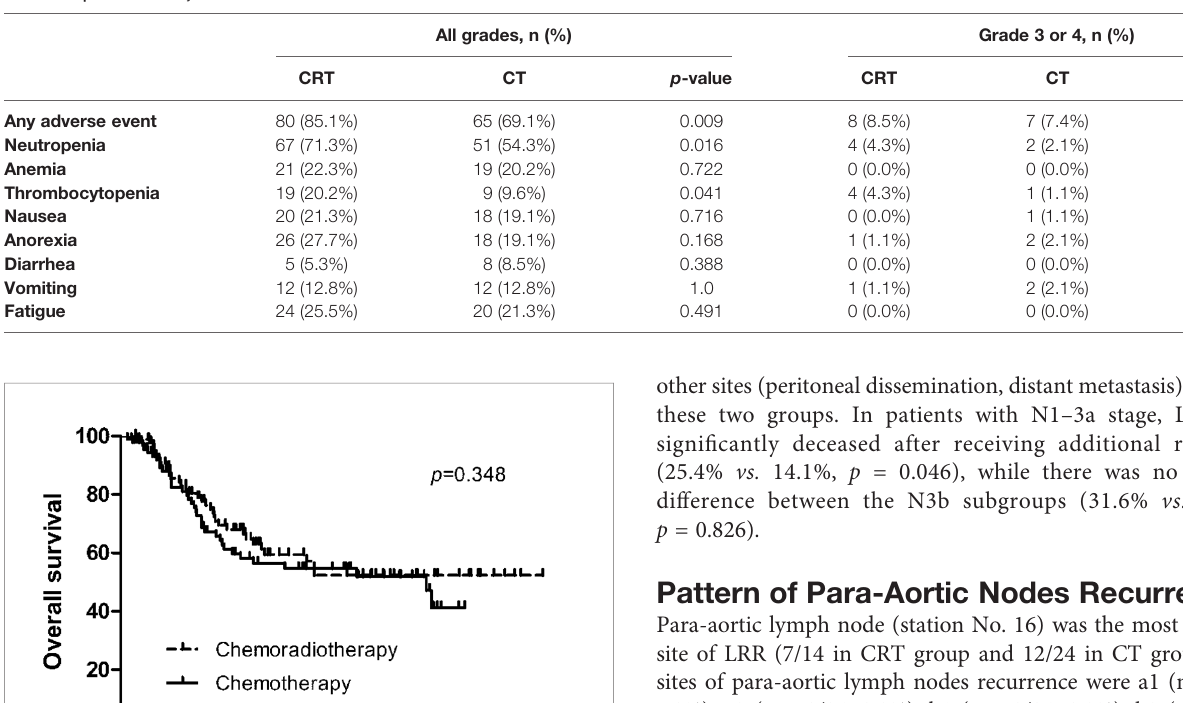
TABLE 2 | Acute toxicity effects.